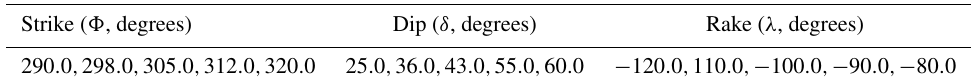
Table 1. Rupture parameters used for each scenario NUM (non-uniform fault model) and UM (uniform slip model). Scenario Length Width Moment Depth Slip Strike Dip Rake distribution NUM 272km 40km 2 . 49 × 10 + 20 Nm − 1 4 to 28km 0 to 3.0m 298 ◦ 43 ◦ − 80 to − 150 ◦ UM 80km 20km 2 . 52 × 10 + 20 Nm − 1 17km 3.6m 312 ◦ 36 ◦ − 90 ◦